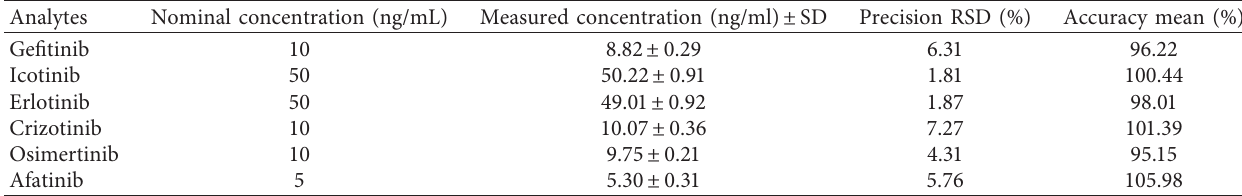
Table 3: Precision and accuracy of the LLOQ of six analytes’ calibration curves.